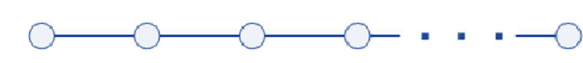
Figure 3. Example of connected network with maximum node level